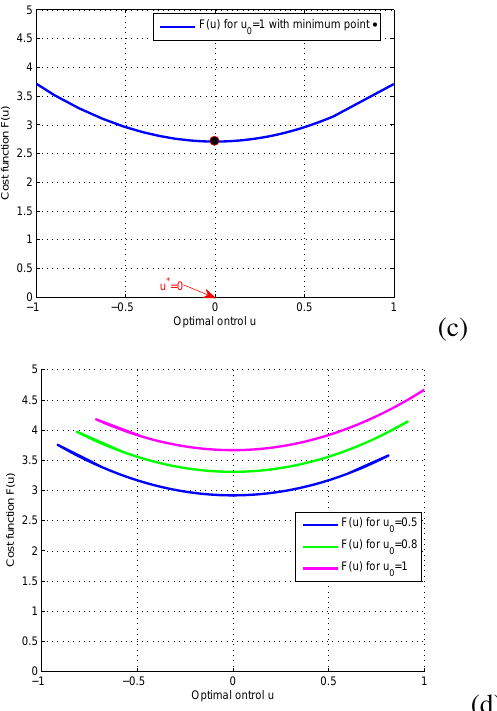
Fig. 4. Numerical Simulationofacostfunction F ( u )